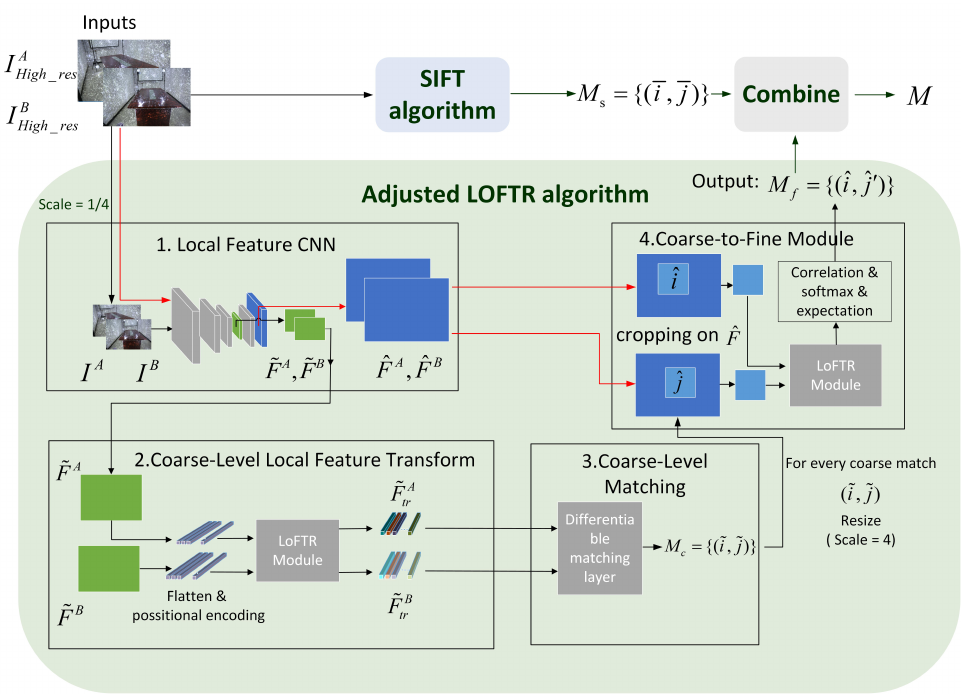
Figure 5. The SIFT combine with LOFTR’s feature extraction and matching process. Where I high _ res is the original resolution image, I is the down sampled image, ˜ F is the scaled image’s coarse-level feature maps, ˆ F is the original resolution image’s fine-level feature maps, ˜ F tr is features pass through the LOFTR module, M c is coarse-level matches set. For each coarse match ( ˜ i , ˜ j ) ∈ M c , the pixel is resized to the original resolution and the pair ( ˆ i , ˆ j ) is retrieved. M f is fine-level matches set also the adjusted LOFTR algorithm’s output. Set M s is the set of matches calculated by SIFT. The final match results are in the set M = M s ∪ M f